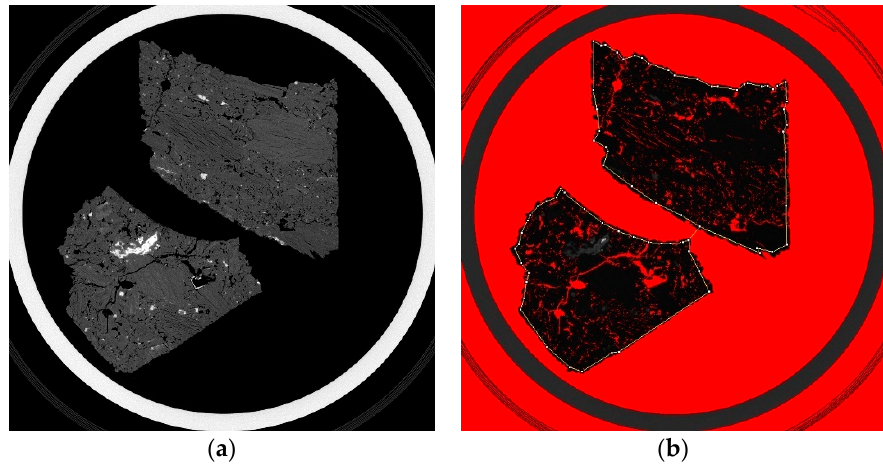
Figure 3. ( a ) An example of a CT image slice; ( b ) ImageJ (https://imagej.nih.gov/ij/, accessed 20/10/2020) was used to analyse the CT image slices. The threshold value was adjusted so that the pores and background was red in colour. The boundaries of the solid particle(s) visible in the CT image slice were manually marked (indicated by the yellow line and white markers).